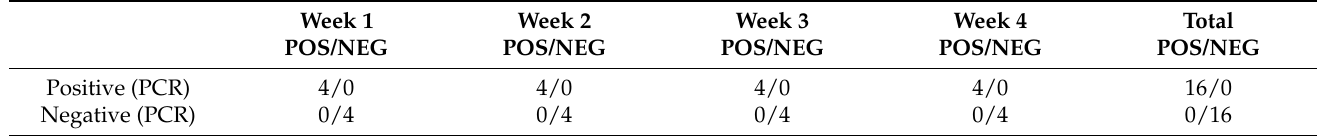
Table 4. Tabulated determination of repeat positive samples and repeat negative samples to be detected over 4 days.